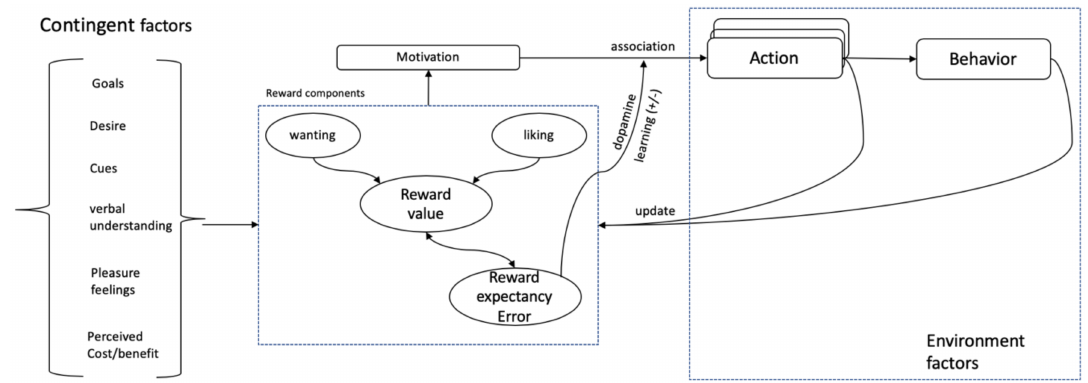
Figure 2. The schematic representation whole process of ‘motivation’ and its links with reward